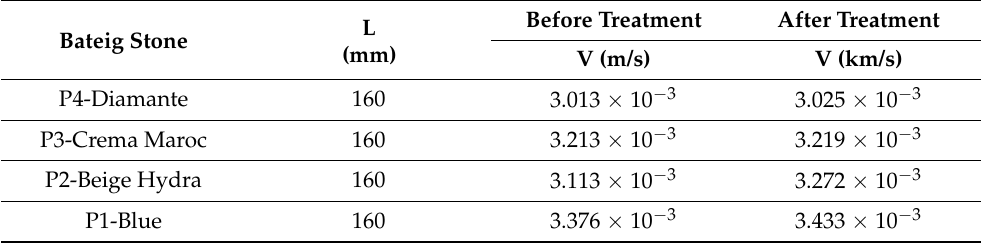
Table 13. Comparison between the values of the impulse propagation rates before and after treatment of Bateig stone specimens (mean values).